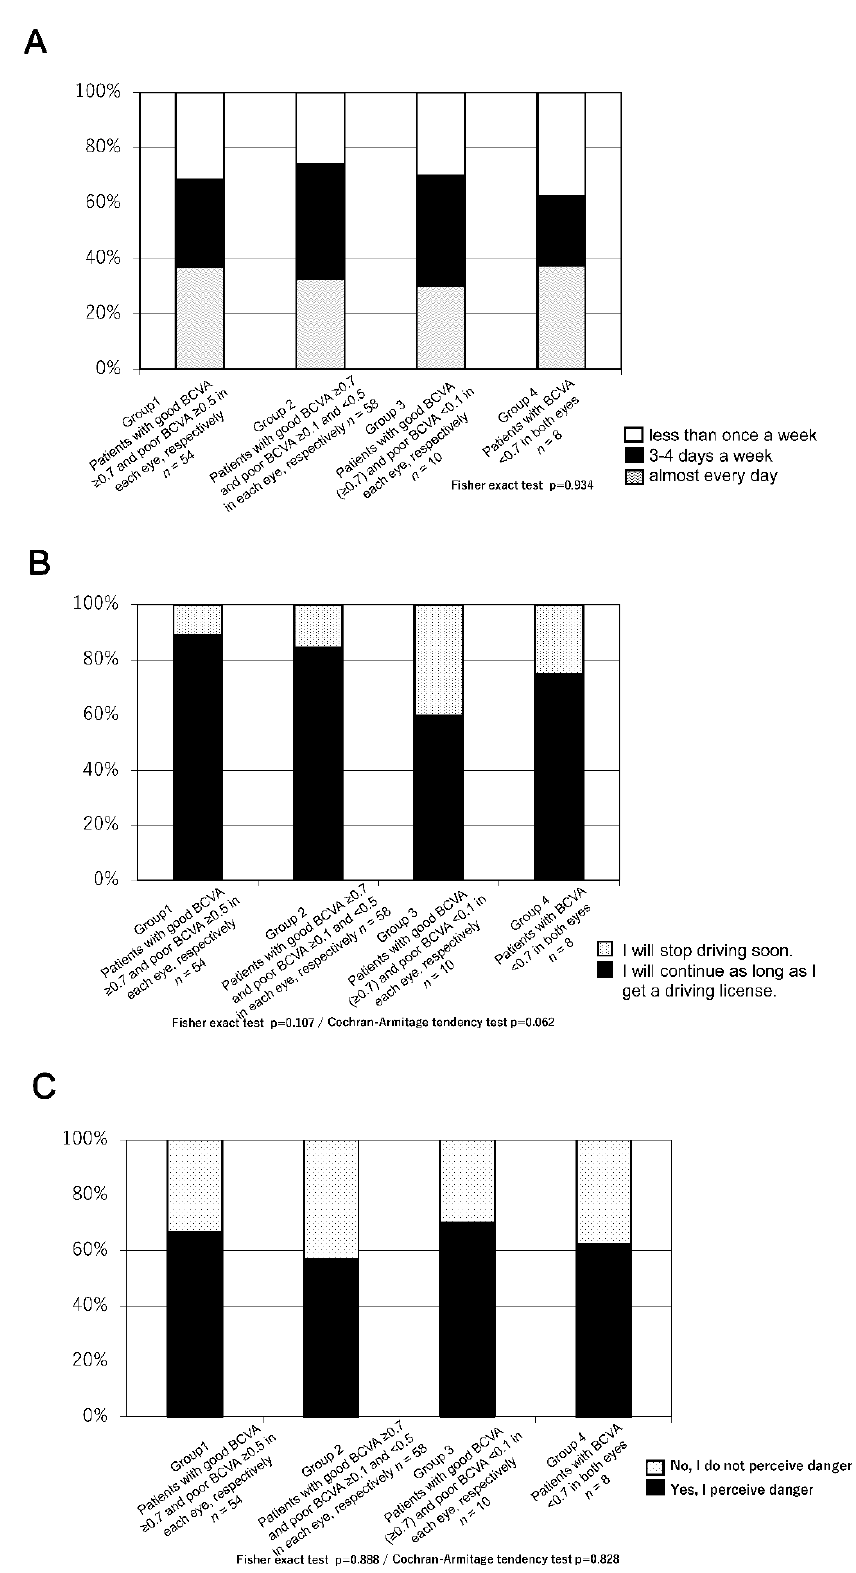
Figure 3. ( A ) Questionnaire results regarding the driving frequency among individuals who continue driving. ( B ) Questionnaire results on whether the patients would continue to drive. ( C ) Questionnaire results on perceiving danger while driving.